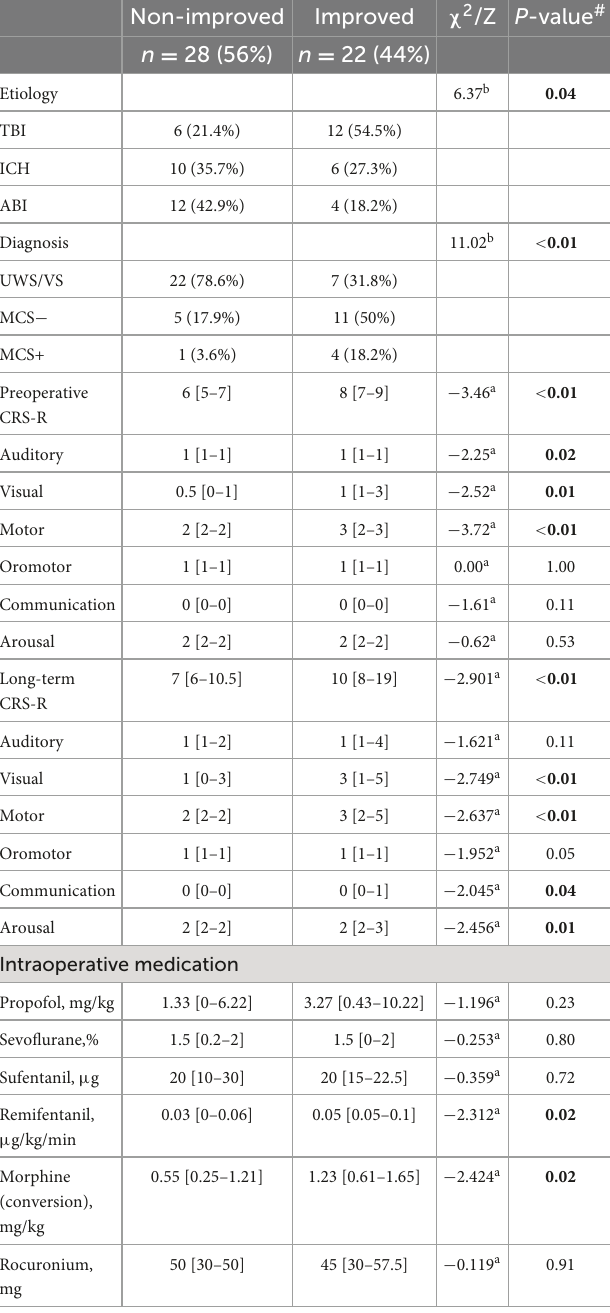
TABLE 2 Clinical characteristics between the improved and non-improved